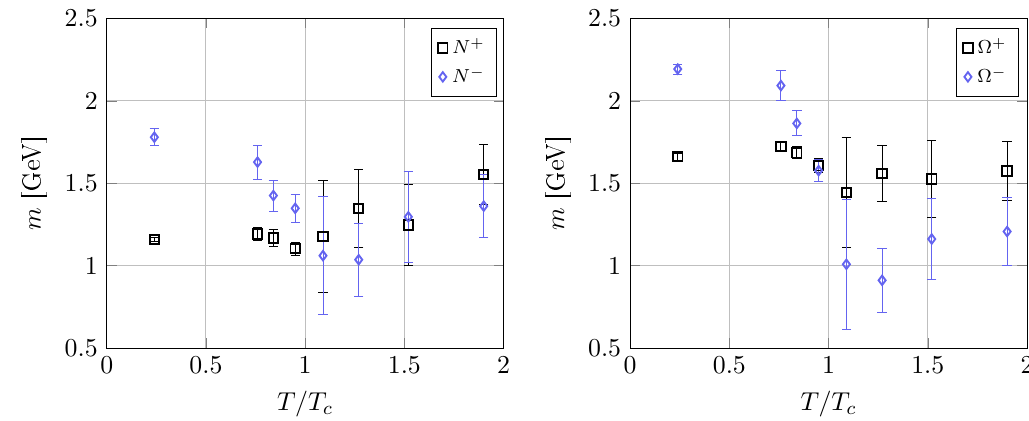
Figure 3 . Groundstate masses in the positive- and negative-parity channels at all temperatures, assuming the exponential decay of eq. (4.2), in the N (left) and (cid:10) (right) channels. also included in table 2. The smaller value of (cid:14) (cid:10) at all four temperatures is due to both m (cid:10) being larger and (cid:14)m (cid:10) being smaller. Both of these e(cid:11)ects are presumably due +